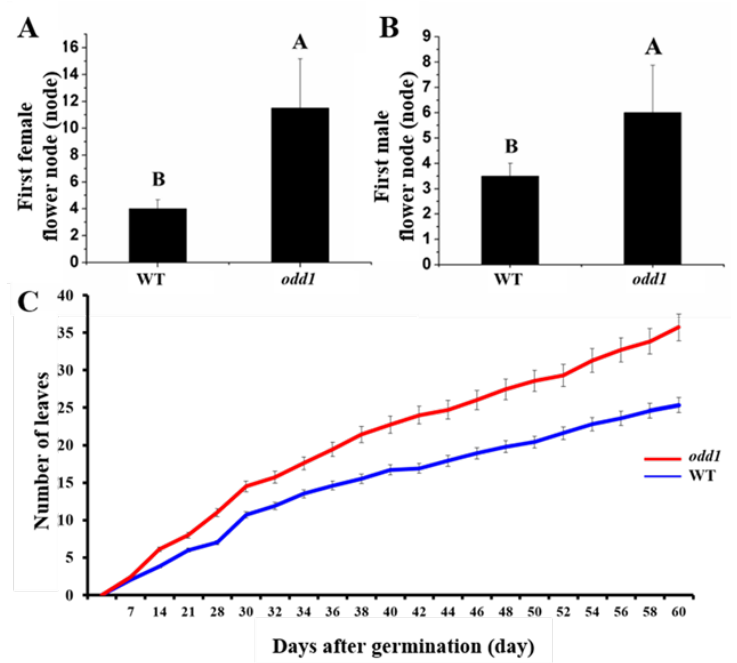
Figure 2. The comparison of first female and male flower position and leaf number between the WT and odd1 mutant. ( A ) First female flower node of odd1 and WT. ( B ) First male flower node of odd1 and WT. ( C ) The leaf number at different developmental stages of odd1 and WT. Different letters indicate very significant differences at p = 0.01 level. Vertical bars represent standard deviation (n =